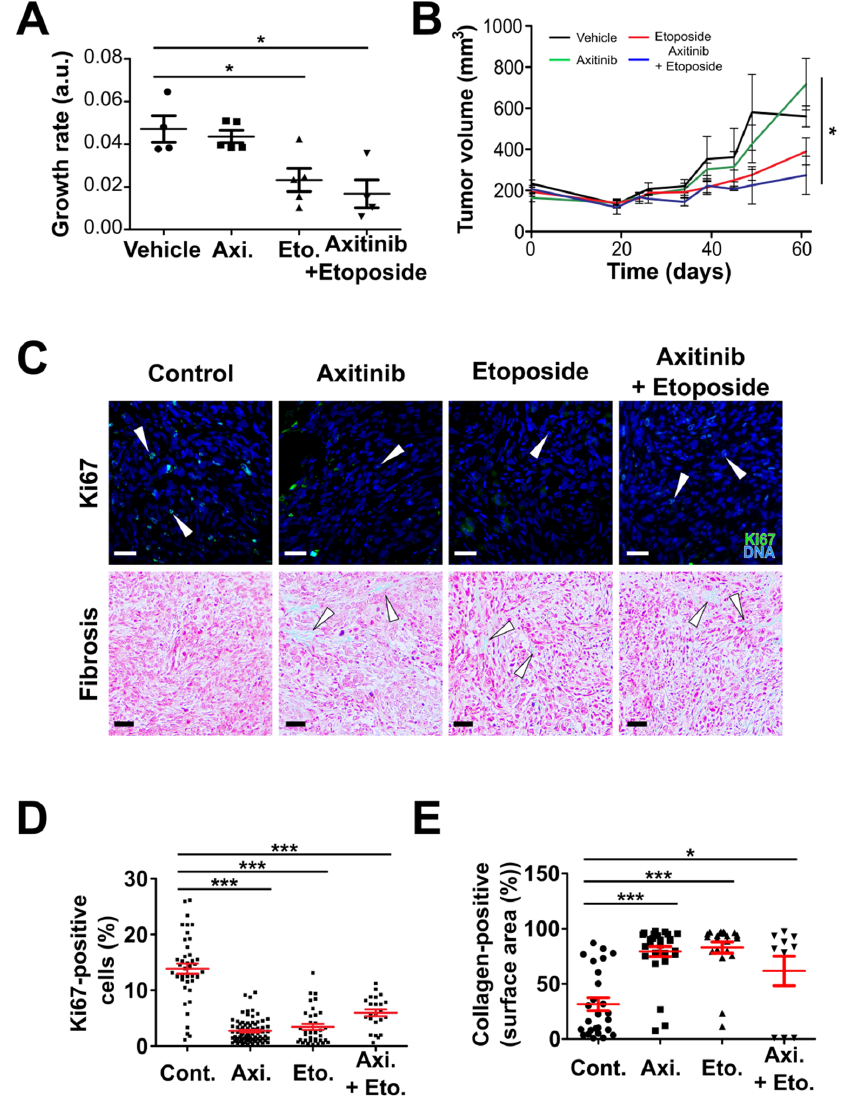
Figure 6. Etoposide and axitinib/etoposide combination reduce subcutaneous DAOY tumor growth and tumor cell proliferation and induce tumoral fibrosis. ( A ) Dot plots showing the growth rate of individual subcutaneous tumors treated with the indicated compounds (horizontal lines and errors bars represent the means ± SEM; * p < 0.05, one-way ANOVA test, the results are statistically nonsignificant unless otherwise stated). ( B ) Mean growth curves of subcutaneous DAOY tumors treated with the indicated compounds (errors bars represent the means ± SEM; * p < 0.05, one-way ANOVA test, the results are statistically nonsignificant unless otherwise stated). ( C–E ) Histological analysis of subcutaneous DAOY xenografts (* p < 0.05, Student’s t-test, the results are statistically nonsignificant unless stated otherwise). ( C ) Representative images of the sections of tumors treated with the indicated compounds. Proliferative cells were revealed by Ki67 immunofluorescent staining (green) and Hoechst33342 nuclear DNA counterstaining (blue) (white arrowheads: Ki67-positive nuclei). Tumoral fibrosis was revealed by Masson’s trichrome staining (nuclei: dark pink; cytoplasm: light pink; collagen: light blue; white arrowheads: collagen-positive areas; scale bars: 100 µM). ( D ) Dot plots representing the quantification of the proportion of Ki67-positive cells in the indicated experimental conditions and ( E ) the proportion of the image fields displaying consistent collagen staining (bars represent the means ± SEM; *** p < 0.001, * p < 0.05, one-way ANOVA test, the results are not statistically significant unless otherwise stated).